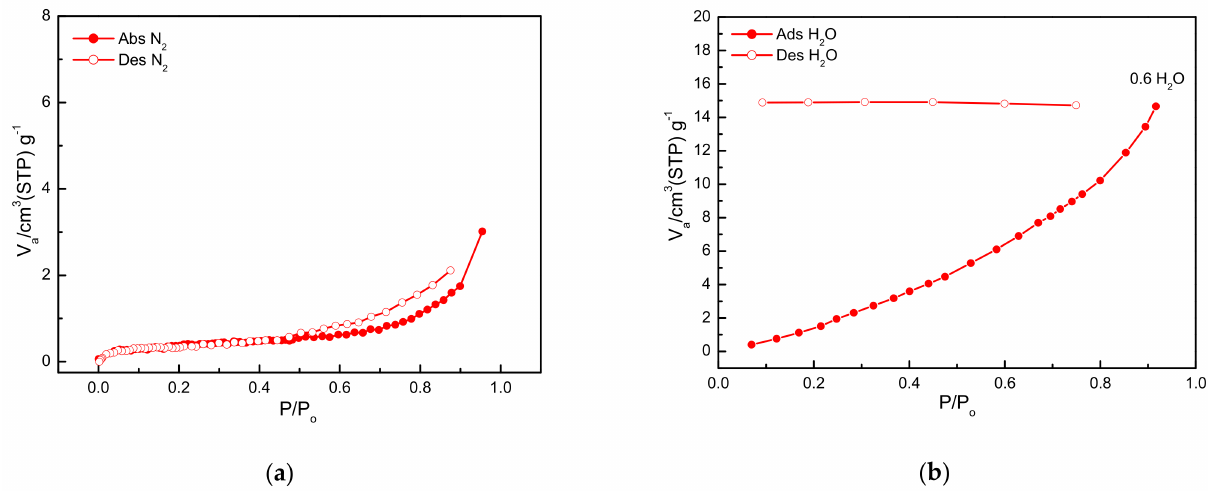
Figure 3. ( a ) N 2 ad-/desorption isotherms of dehydrated species 1 at 77 K; ( b ) H 2 O ad-/desorption isotherms of dehydrated species 1 at 298